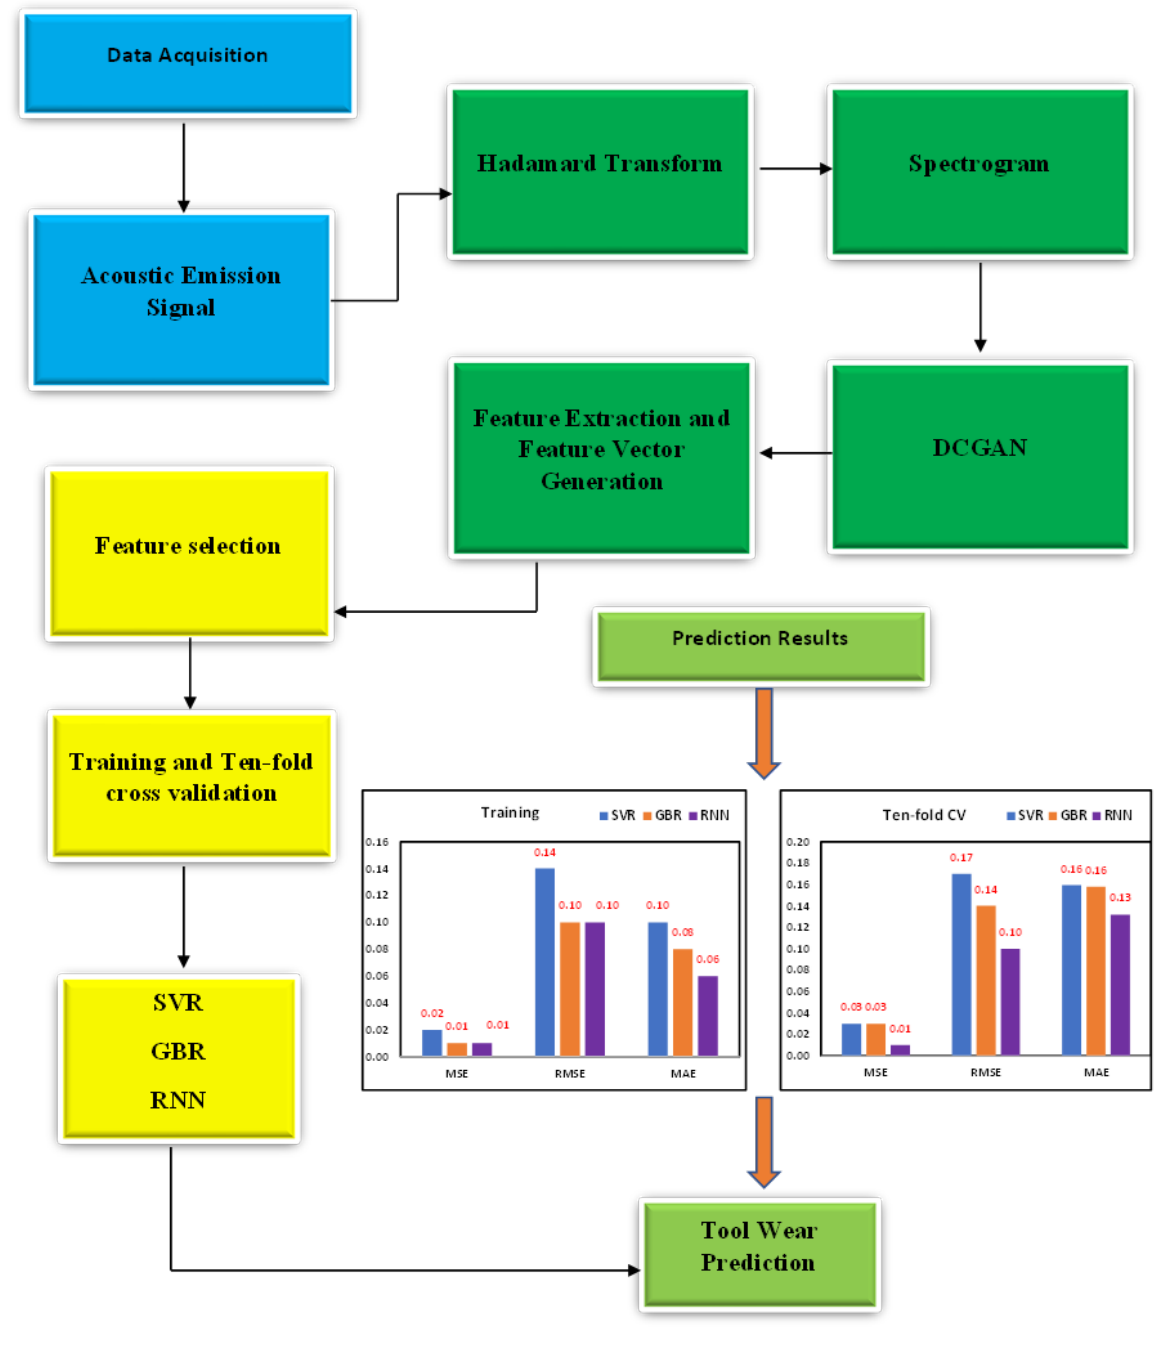
Figure 1. Proposed methodology.